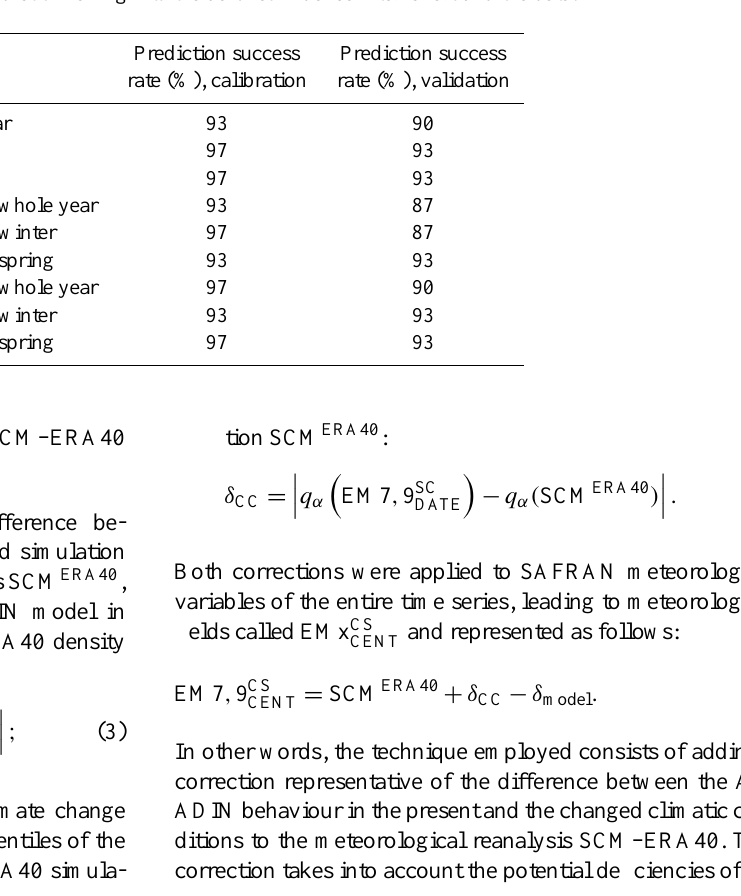
Table 4. Predictive performance of CI regression models in cross validation, where each year is included or not in the calibration sample. The success rate corresponds to the percentage of prediction falling into the 95% confidence interval around the